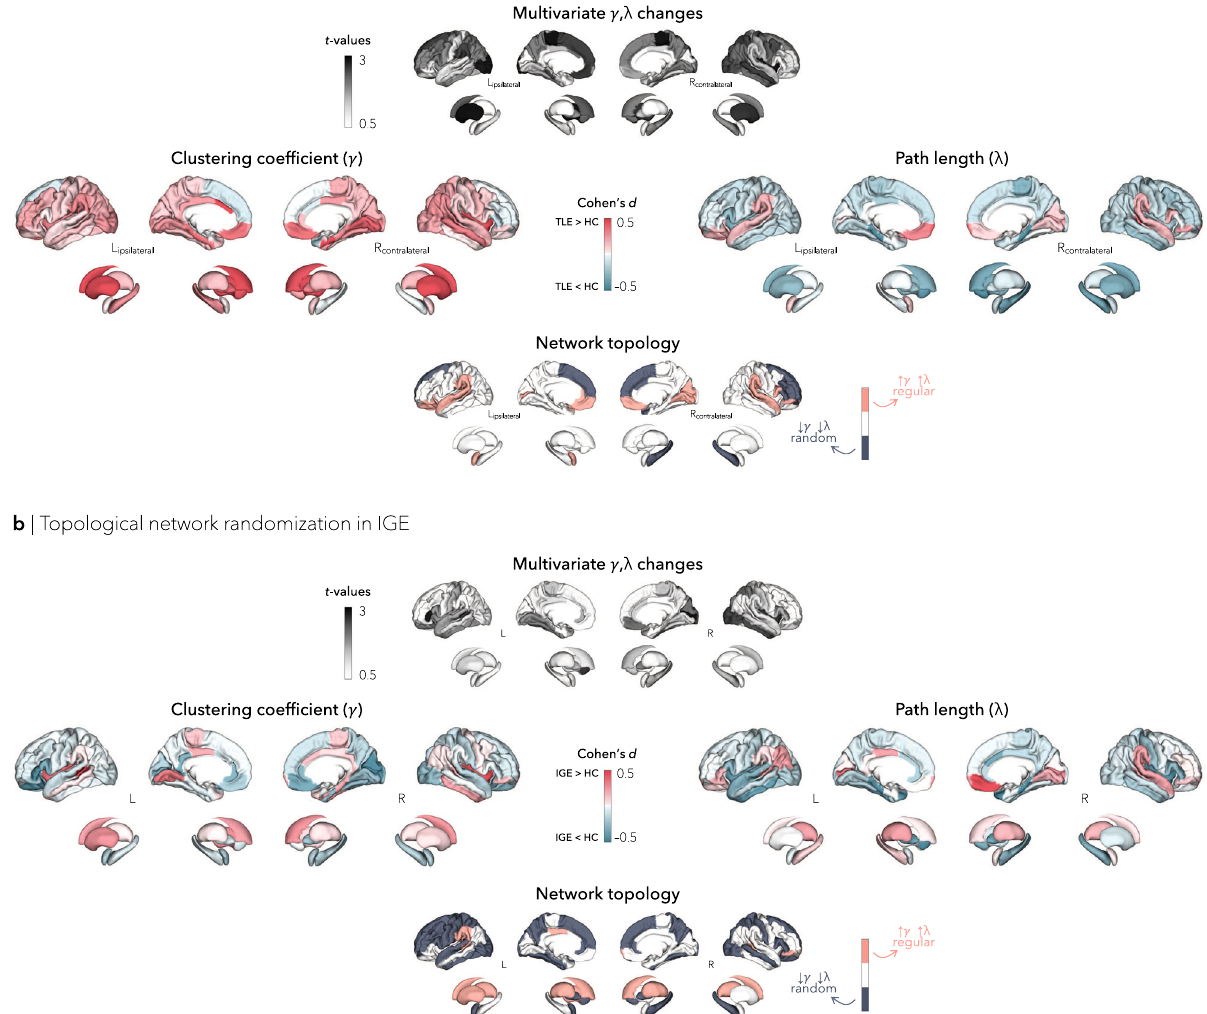
Fig. 2 Nodal network alterations. a Graph theoretical analysis of structural covariance between individuals with TLE and controls revealed increased clustering and path length in bilateral orbitofrontal, temporal, and angular cortices, caudate, and putamen, as well as ipsilateral amygdala, revealing a regularized, “ lattice-like, ” arrangement. b In IGE, widespread multivariate topological alterations were observed in bilateral fronto-temporo-parietal cortices, right nucleus accumbens, and left pallidum. Clustering and path length effect sizes in these regions suggest a randomized network con fi guration (decreased clustering and path length). HC = healthy control, IGE = idiopathic generalized epilepsy, TLE = temporal